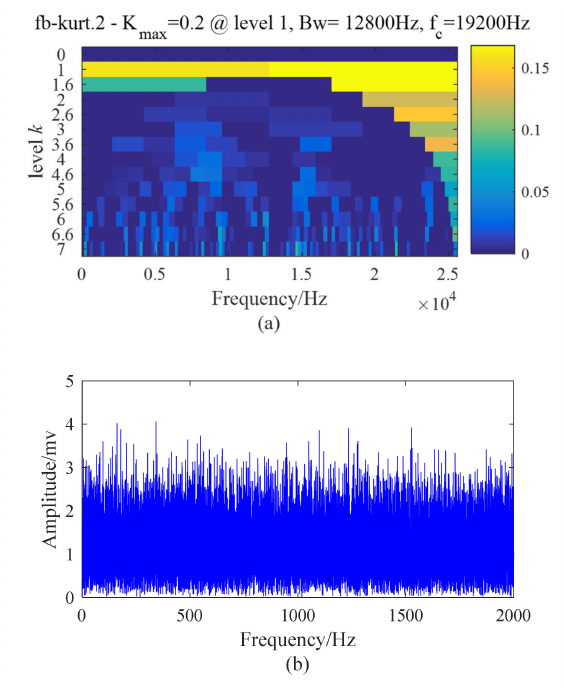
Figure 12. The diagnosis result of the simulation signal of the bearing with the outer race fault processed by the Fast Kurtogram (FK) method: ( a ) the kurtogram result; ( b ) the squared envelope spectrum